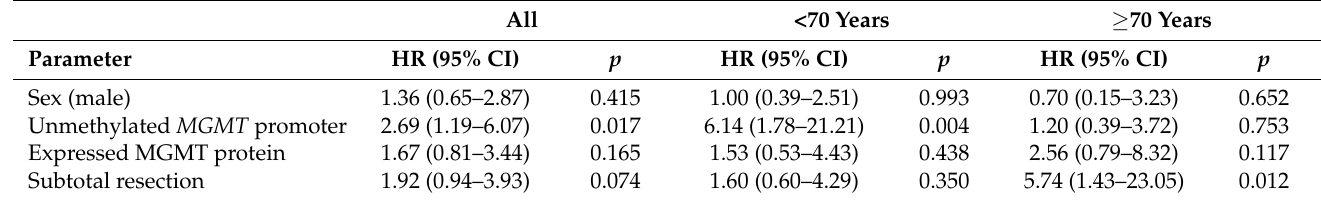
Table 4. Multivariate Cox proportional hazard model of OS in patients with GBM. The data are shown for all patients (All), patients younger than 70 years of age (<70 years) and patients with an age of 70 years or more ( ≥ 70 years). References in the model were female sex, methylated MGMT promoter, low MGMT protein expression and gross total resection. The hazard ratio (HR), the 95% confidence interval (CI) and the corresponding p -value are listed.